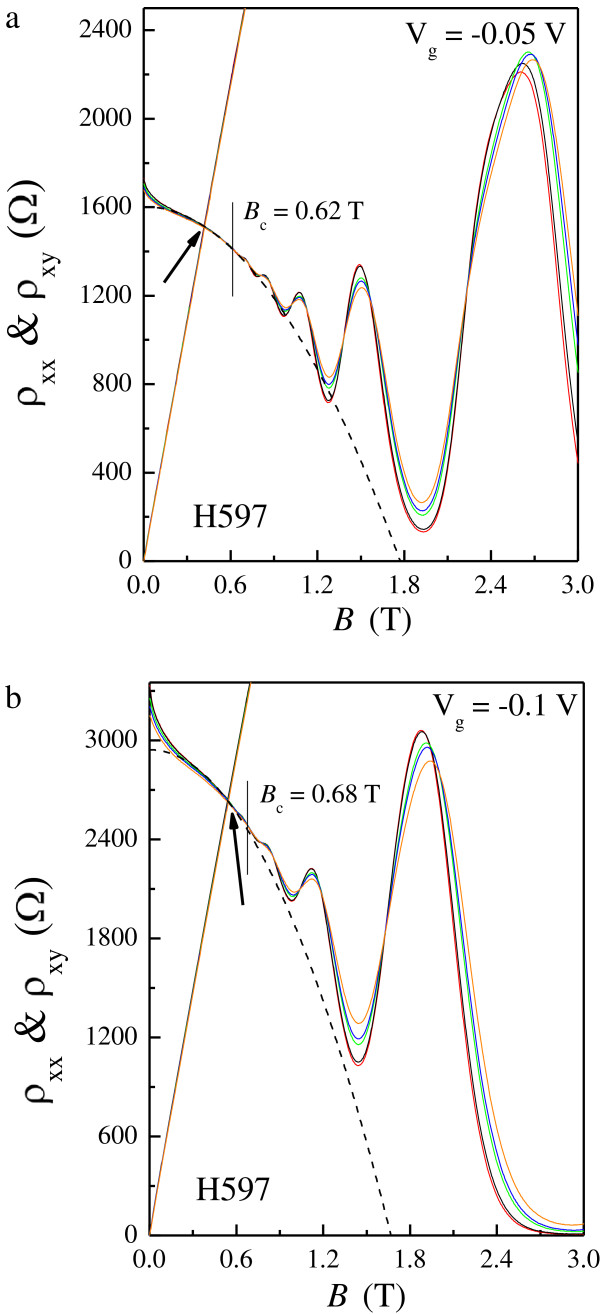
ρxx and ρxy as functions of B at various T ranging from 0. 3 to 2 K. For (a)Vg = −0.05 V and (b)Vg = −0.1 V.